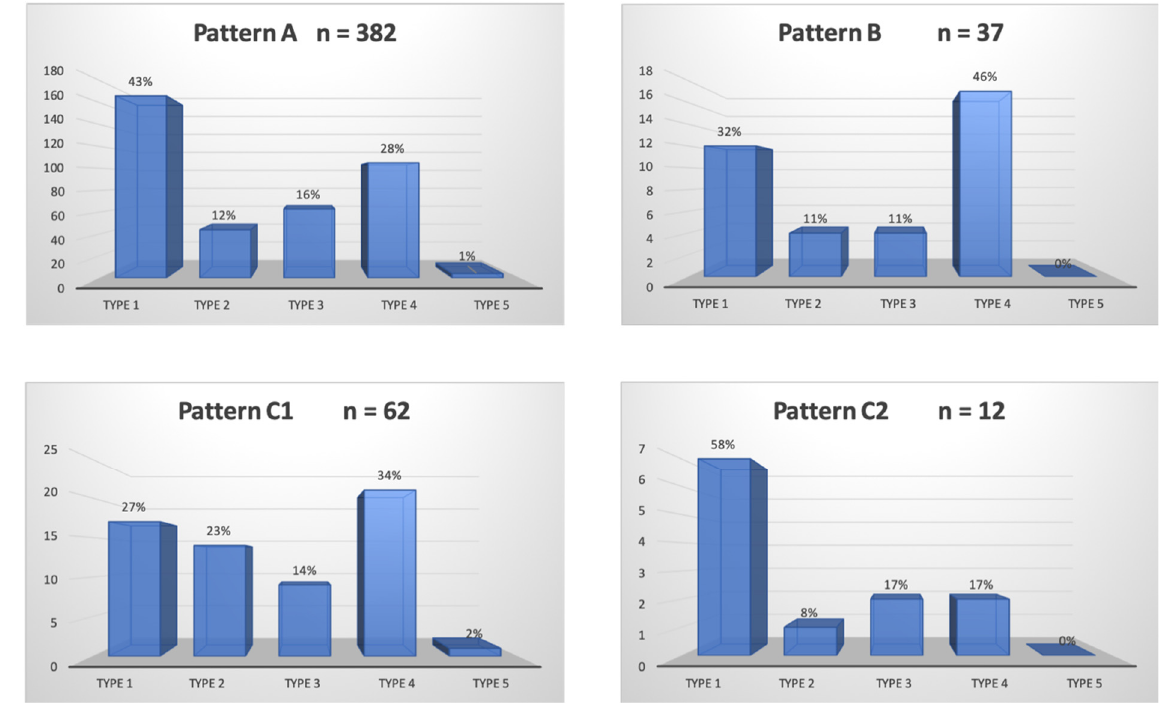
Figure 4. Distribution in study cohort of the patterns of the solitary prostatic arteries according to the different origins. Patterns A, B, and C1 and C2 correspond to the different intra/extra-prostatic supplies of the prostatic artery in the case of a solitary PA (one artery per side, n = 493/622 (79.3%) in this study), according to the Amouyal classification. The values are presented as number, n . Types 1 to 5 represent the possible origins of the PA, according to the Assis classification. The values are presented as a percentage, %.